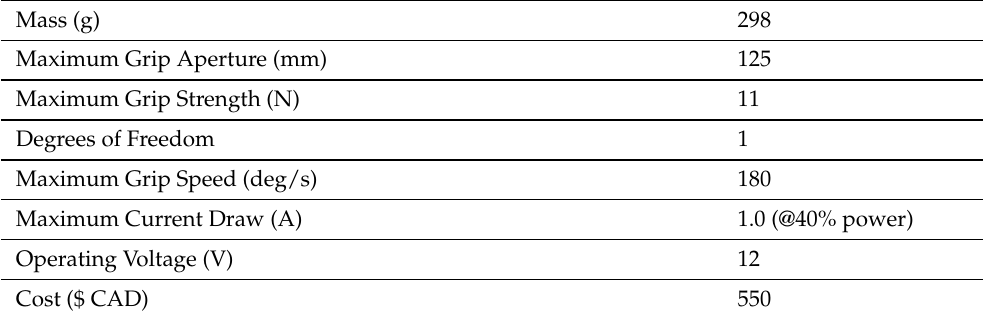
Figure 6. Exploded and section views of a finger with a compliant sensor. (1) PLA finger, (2) compliant Table 1. 3D-printed prosthetic hand specification